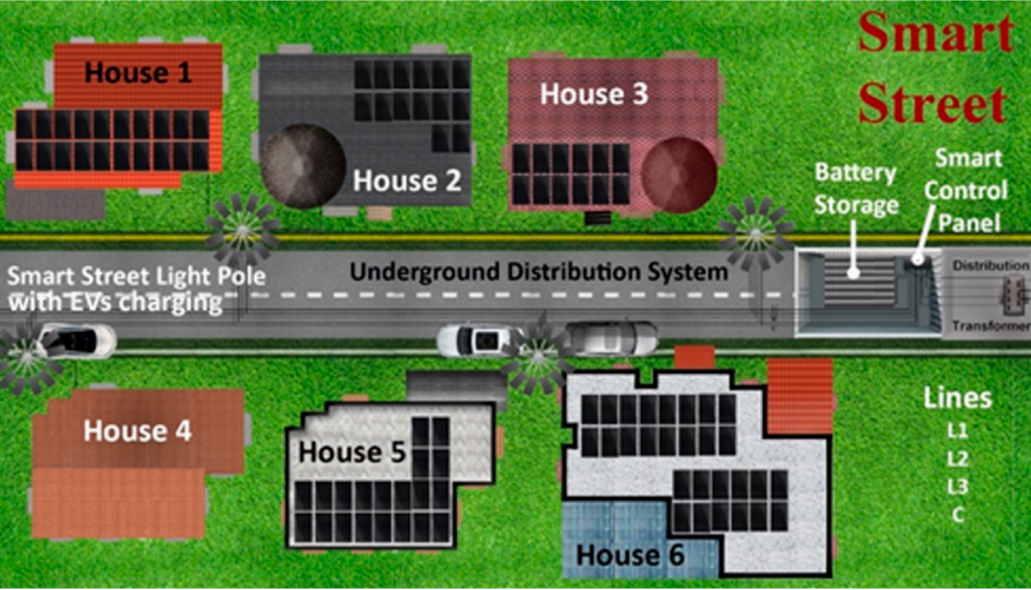
Figure 1. Design of the Smart